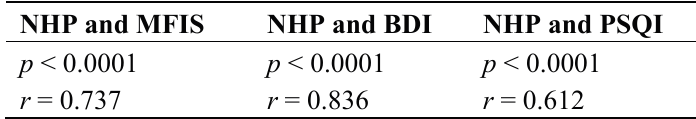
Table 6. Non parametric correlations (Spearman-Rho) between NHP and other questionnaires (Beck Depression Inventory and Pittsburgh Sleep Quality